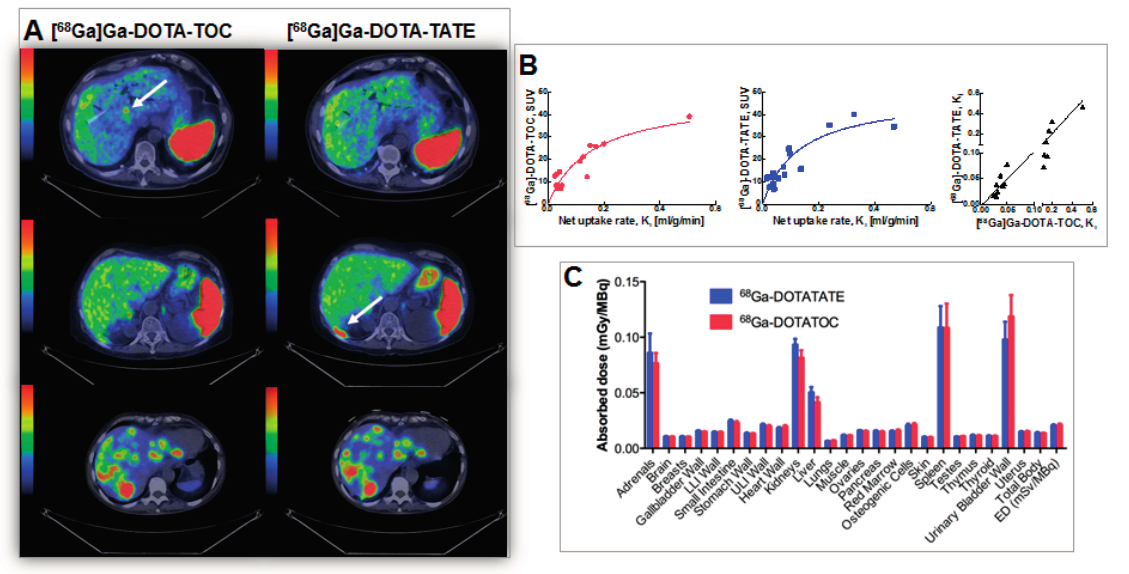
Figure 17. ( A ) Transaxial PET/CT fusion images of liver demonstrating cases of higher detection rate for: [ 68 Ga]Ga-DOTA-TOC ( A , upper panel ); [ 68 Ga]Ga-DOTA-TATE ( A , middle panel ); as well as equal detection rate (A, lower panel). Whole-body scans were conducted at 1 h p.i.. Arrows point at hepatic metastases; ( B ) SUV is presented as a function of net uptake rate K i in tumors for [ 68 Ga]Ga-DOTA-TOC ( red ) and [ 68 Ga]-DOTA-TATE ( blue ). The solid lines are hyperbolic fits and are for visualization purposes only. Correlation between net uptake rate K i at 1 h p.i. for [ 68 Ga]Ga-DOTA-TOC and [ 68 Ga]Ga-DOTA-TATE ( black ). The solid line is Deming regression with slope 1.06 and intercept 0.0. The axes are split in order to clarify the relationship at low uptake rates; ( C ) Absorbed doses in all organs included in OLINDA/EXM 1.1. LLI: lower large intestine; ULI: upper large intestine; ED: effective dose. Error bars indicate standard error of the